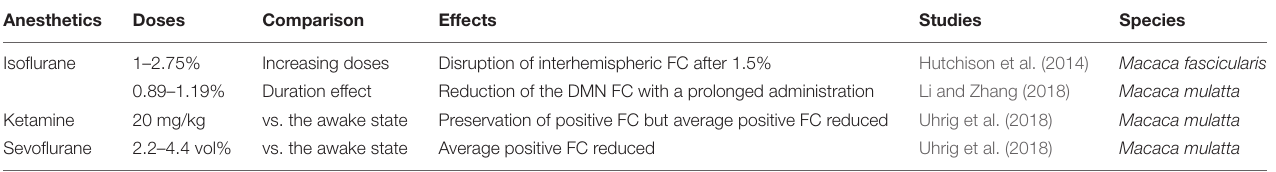
TABLE 2 | Anesthetics effects on the functional connectivity in primates.